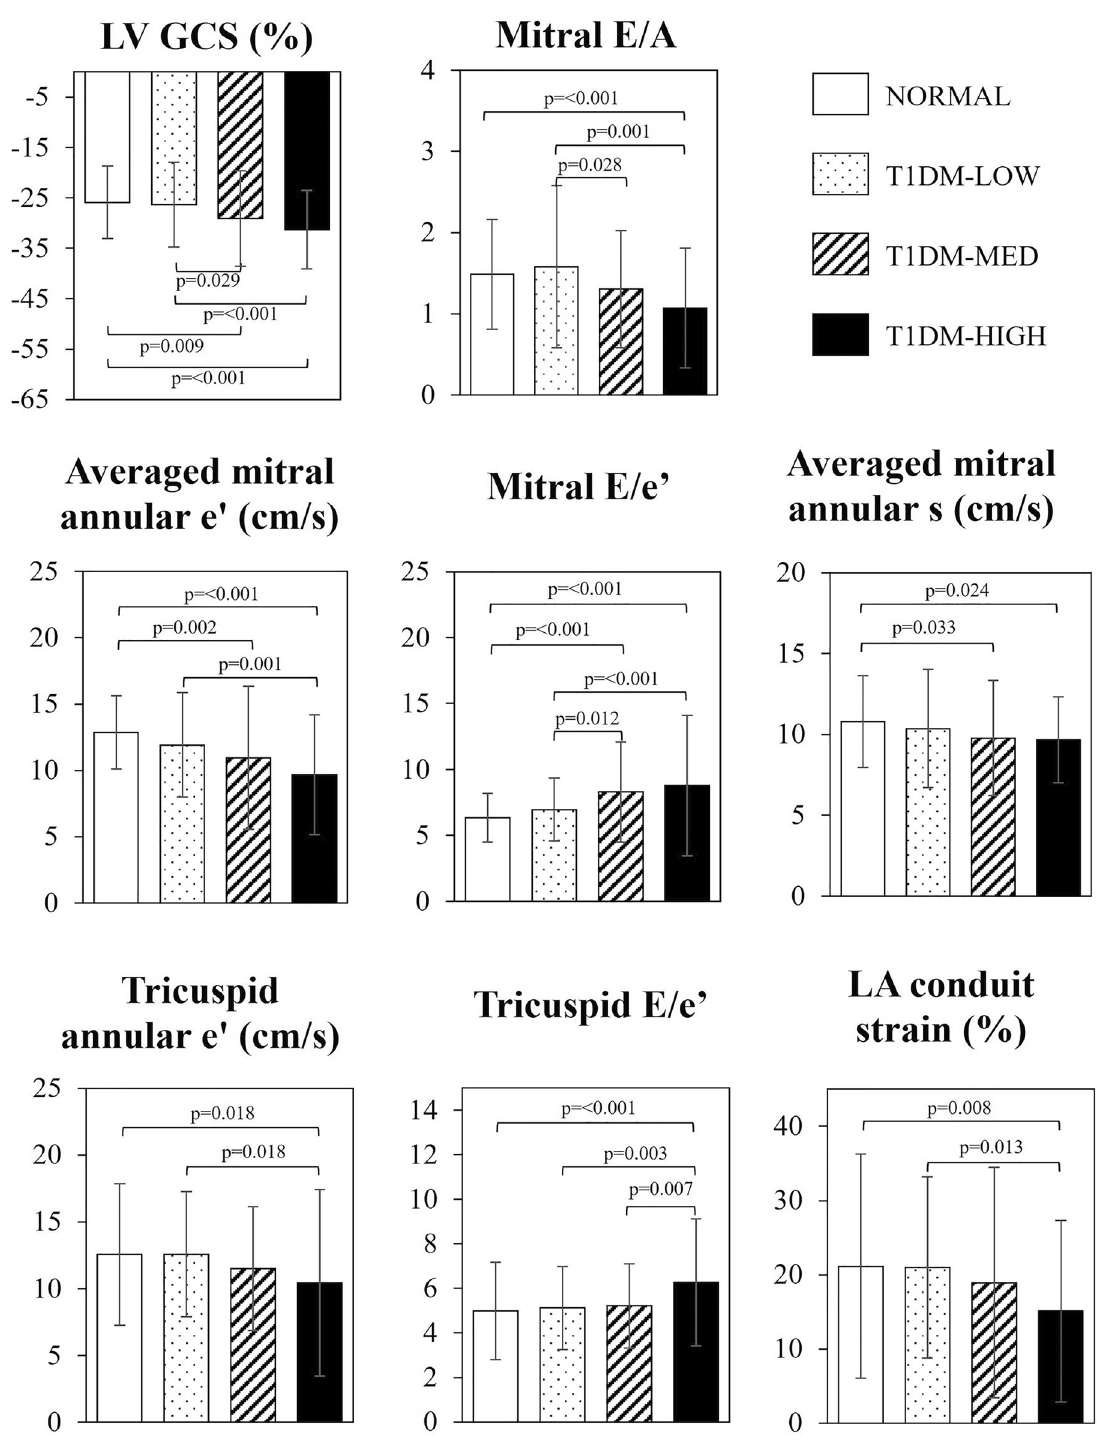
Figure 3. Comparison of echocardiographic variables among healthy subjects and T1DM